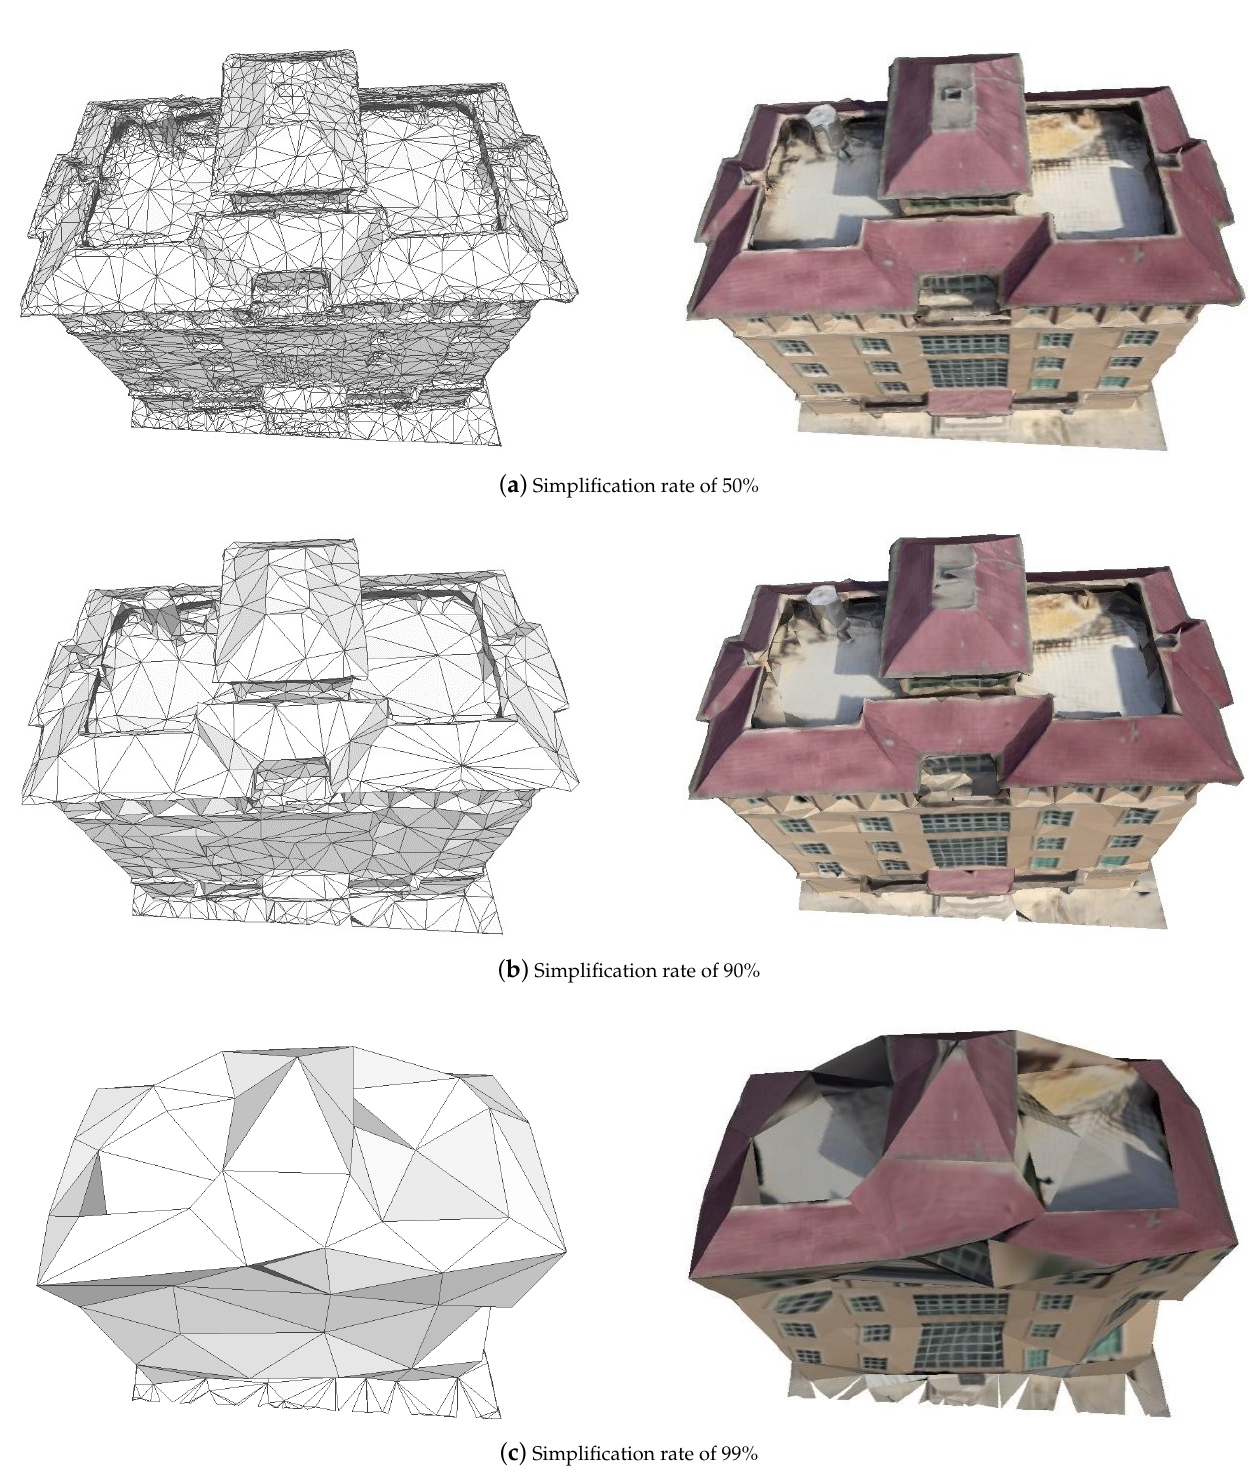
Figure 12. Simplified meshes in the QEM algorithm. ( a ) Simplification rate of 50% (36,841 faces). ( b ) Simplification rate of 90% (3682 faces). ( c ) Simplification rate of 99% (365